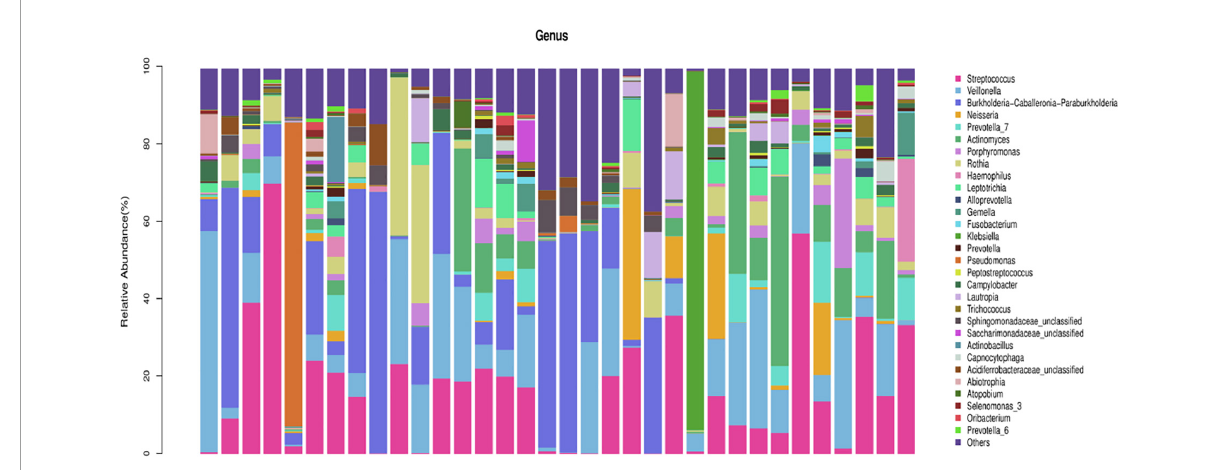
FIGURE4 Composition of horizontal bacterial flora in the airway microecology of the acute exacerbation of chronic obstructive pulmonary disease (AECOPD) group.